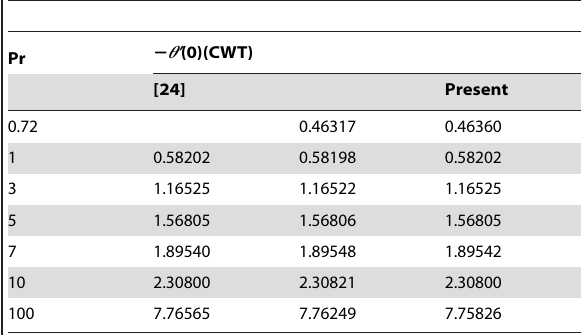
Figure 7. Influence of c on temperature profile h ( g ) when n ~ 0 : 5 :